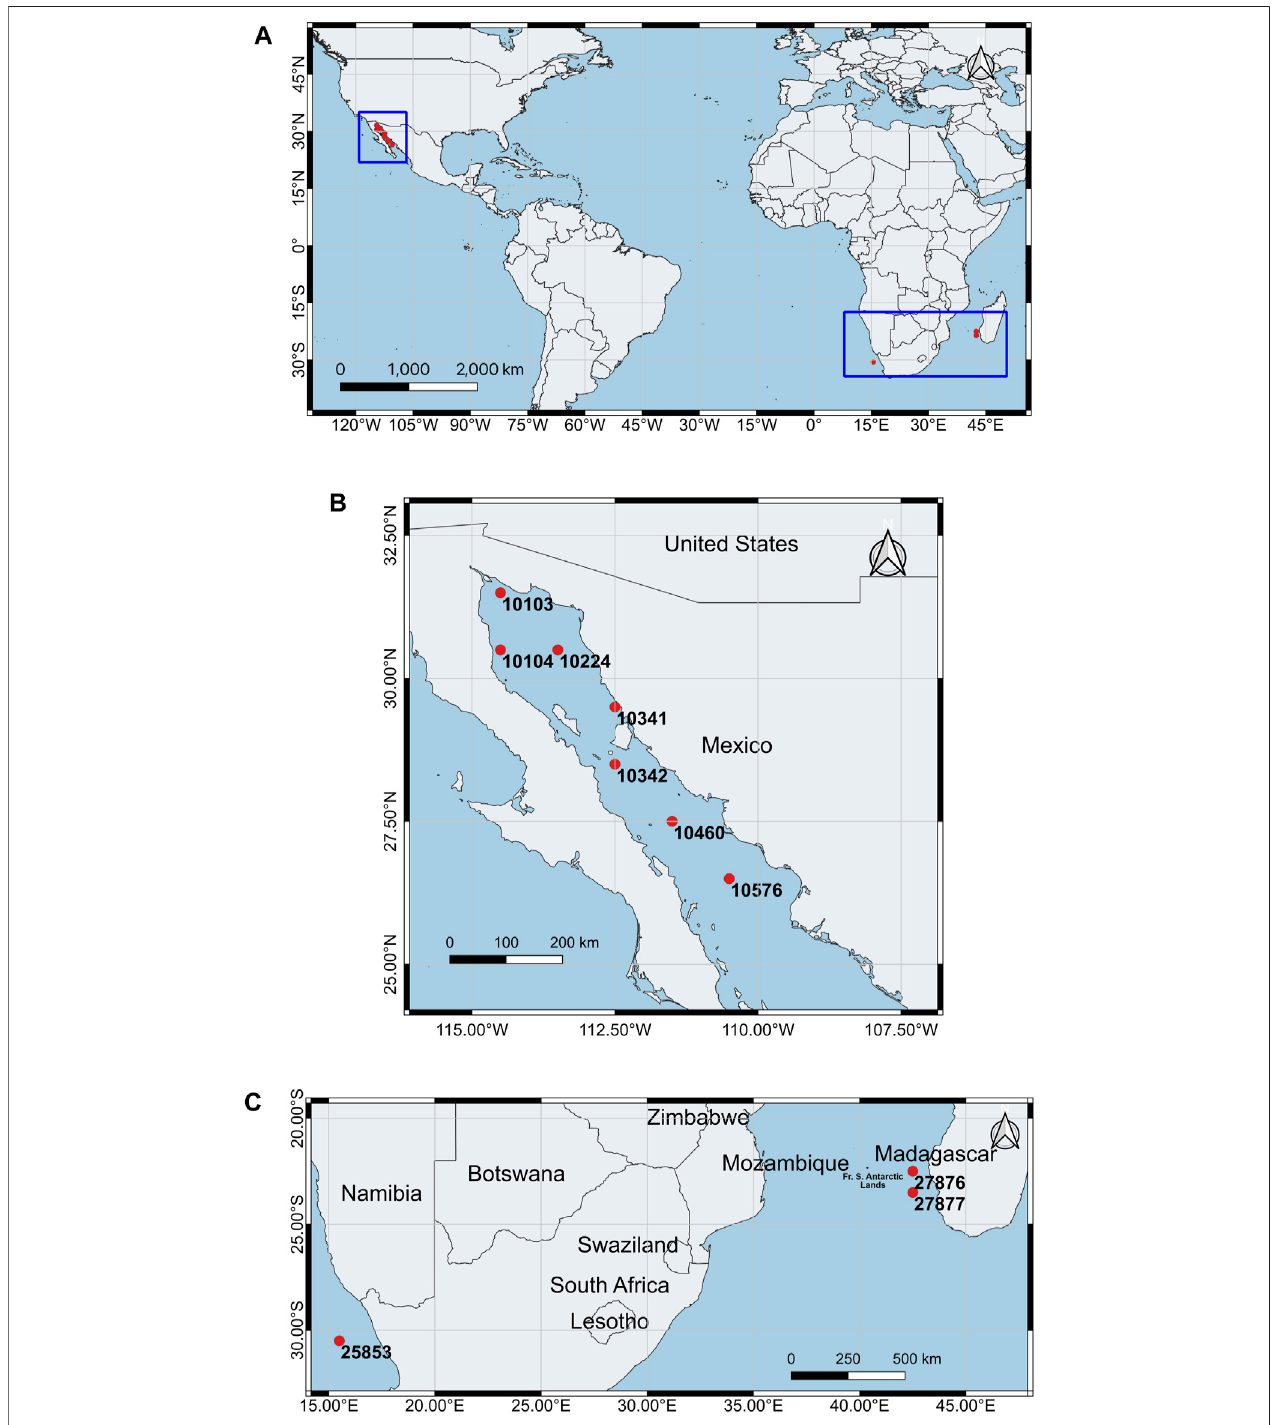
FIGURE 1 | 10 sea surface chlorophyll data locations. (A) shows the distribution of the 10 data locations at a global scale, while the zoom-in views of the two rectangles are shown in (B) and (C) . The number represents the identity of each data location.